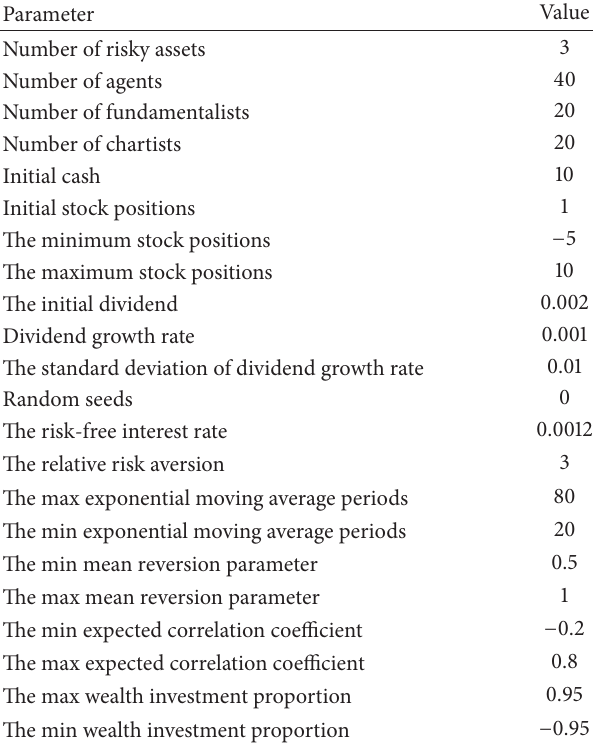
Table 1: The parameters of basic